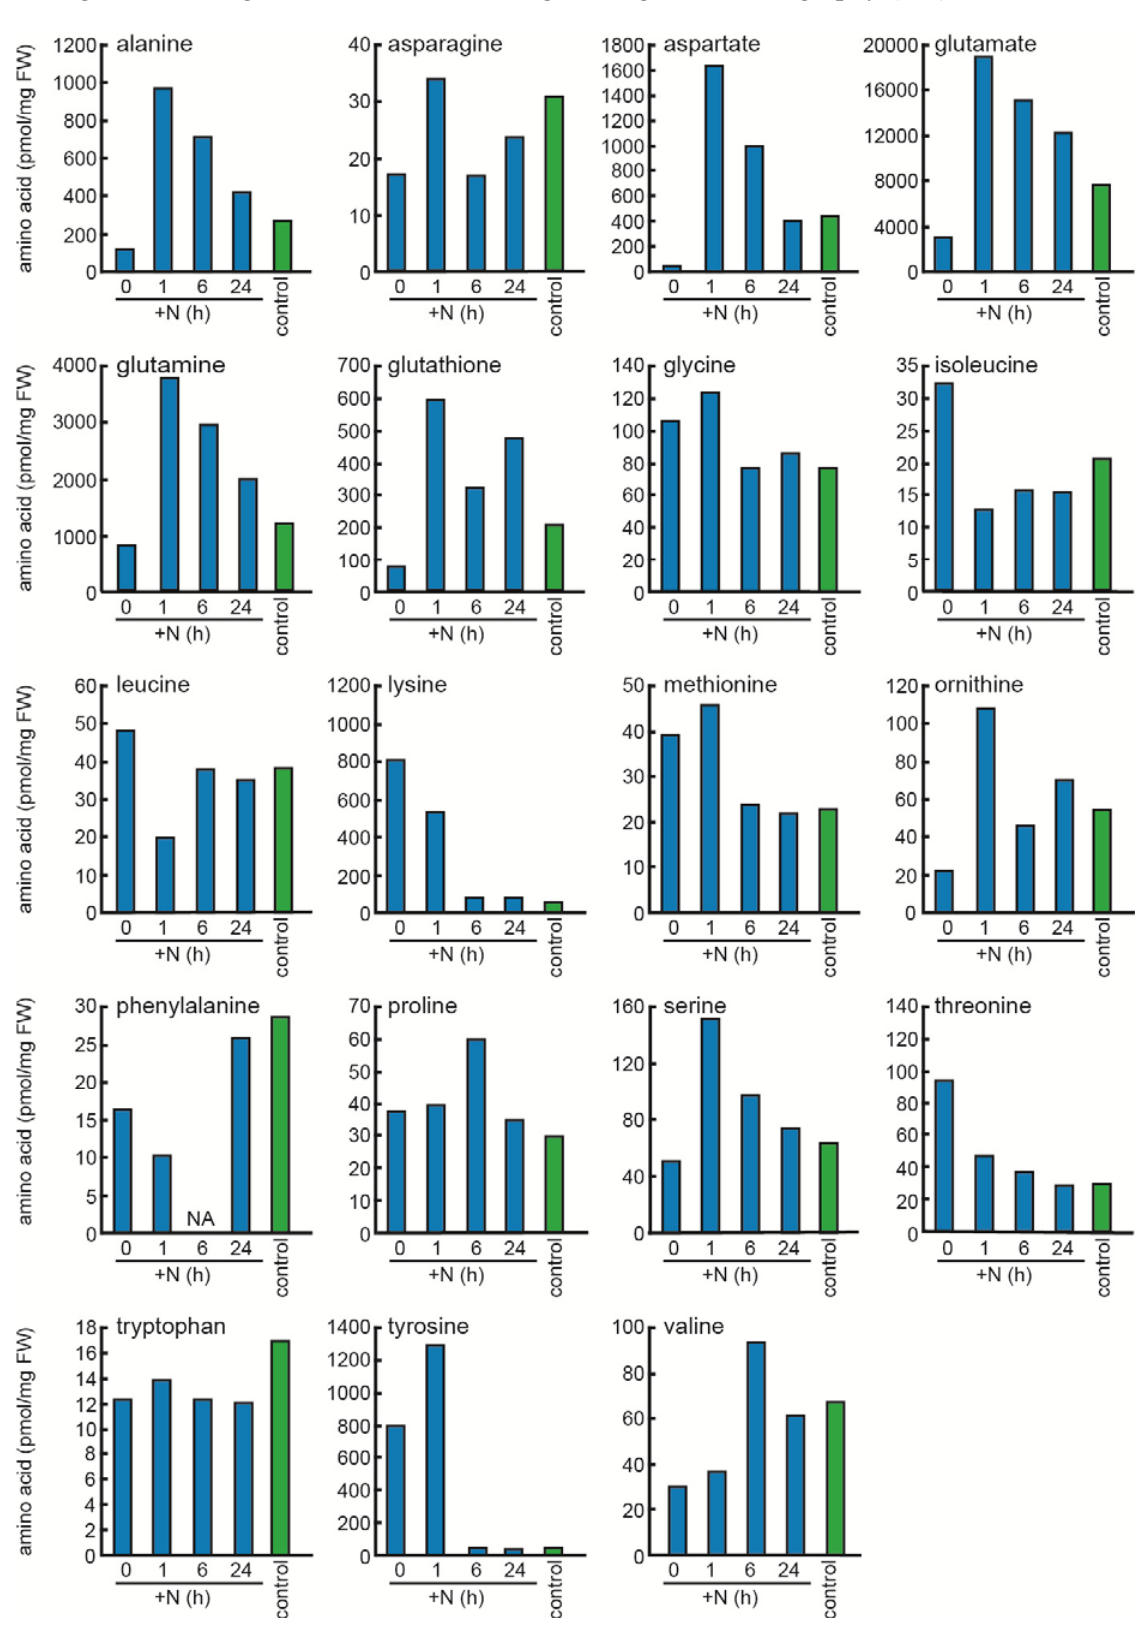
Figure 3. Effects of nitrogen re-addition on the amino acid pools of Synechocystis cells that were nitrogen starved for 24 h. Blue bars: cells nitrogen starved for 24 h (0 h), or then cultured after re-addition of nitrate (1, 6, 24 h). Green bars: control cells grown under nitrogen containing condition. NA, not assigned in gas chromatography